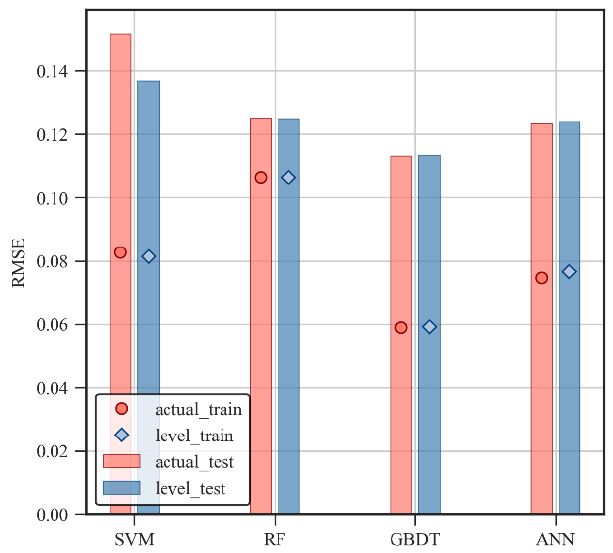
Figure 19. The RMSE of RT by data processing for absorption coefficient. Table 9. Model result by data processing for absorption